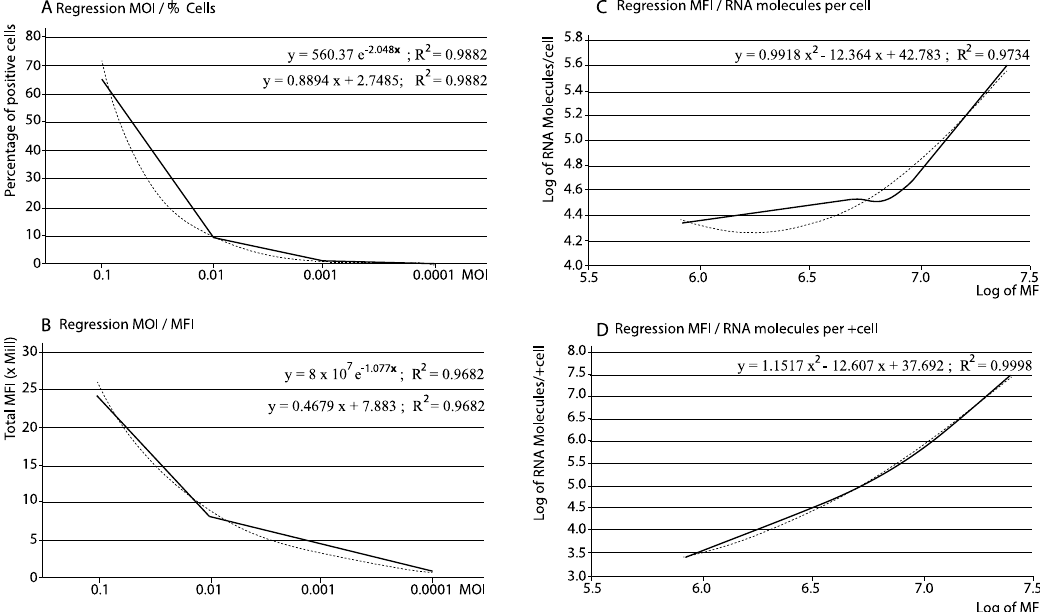
Figure 1. Correlation between multiplicity of infection (MOI), infected cells, Mean of Fluorescence Intensity (MFI) and RNA molecules. Each data corresponds to a single data point. ( A ) Regression between MOI and percentage of infected cells; ( B ) Regression between MOI and MFI; ( C ) Regression between MFI and viral RNA copies per cell; ( D ) Regression between MFI and viral RNA copies per positive cells. In graphs with 2 equations, the first one corresponds to a regression line equation (and R 2 value) using the values shown on both axes; the second one corresponds to a regression line equation (and R 2 value) using logarithm of the values shown on both axes. Dashed lines: regression curves. Table 1. Preliminary assays to evaluate the performance of the method for discrimination between different virus